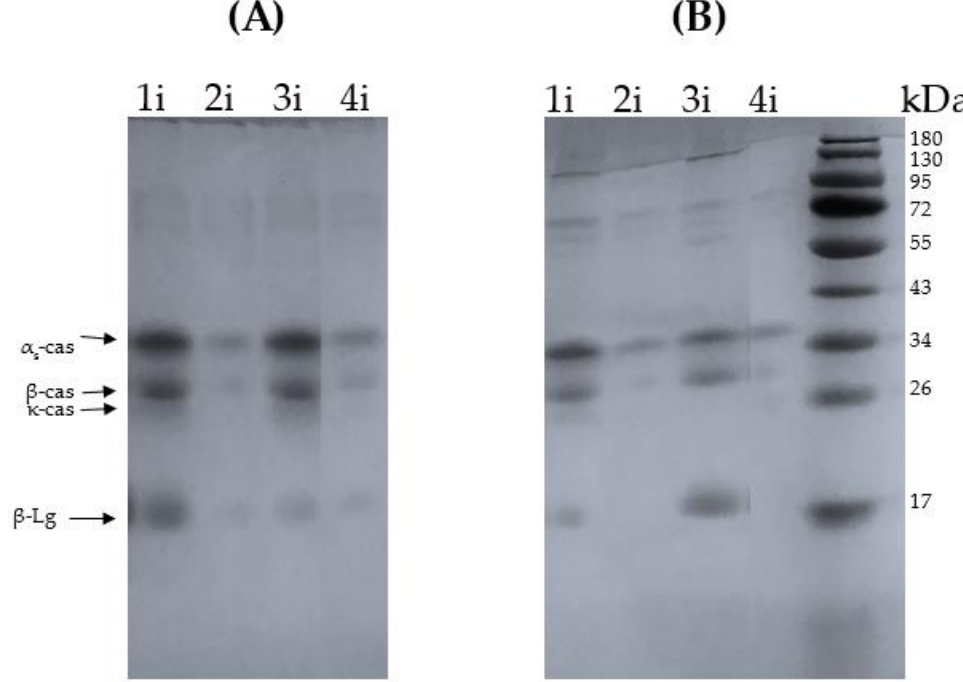
Figure 7. Reducing ( A ) and nonreducing ( B ) SDS-PAGE analysis of the proteins adsorbed at the oil – water interfaces from the 50%-75 °C (1i), 50%-100 °C (2i), 60%-75 °C (3i), and 60%-100 °C (4i) IMFs. β -Lg = β -lactoglobulin, cas = casein.